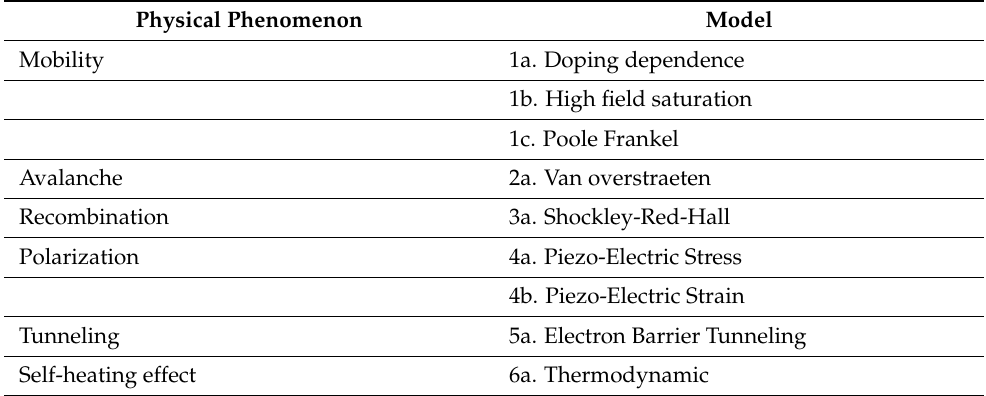
Table 1. Models used in GaN device simulation.